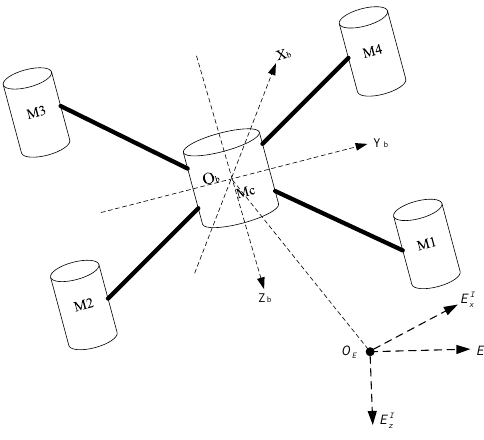
Figure 1. Schematic of the